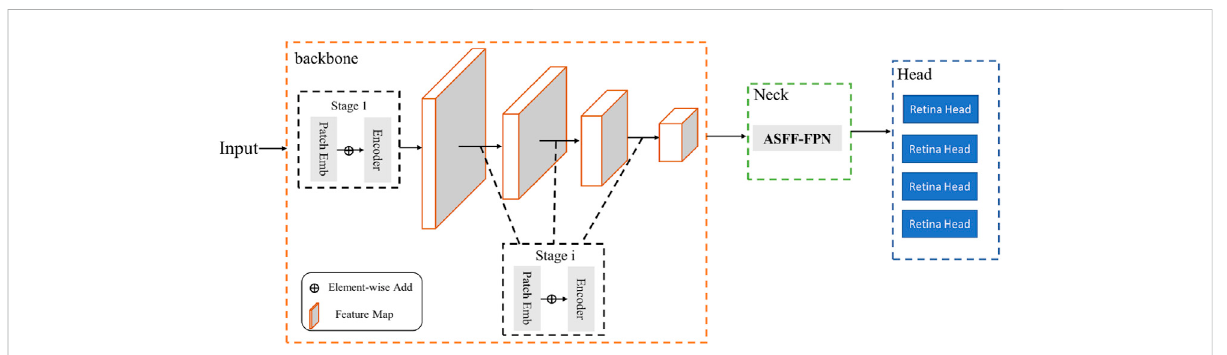
FIGURE 2 The structure of MDPNet.